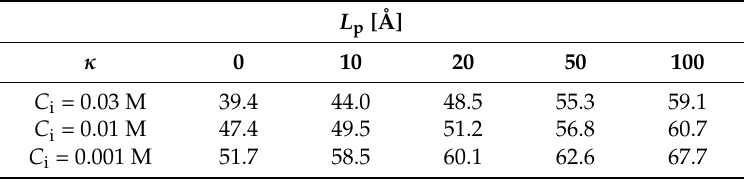
Table 1. Persistence length L p (Å) of the cationic polymers for various chain rigidity parameters κ at different salt concentrations C i